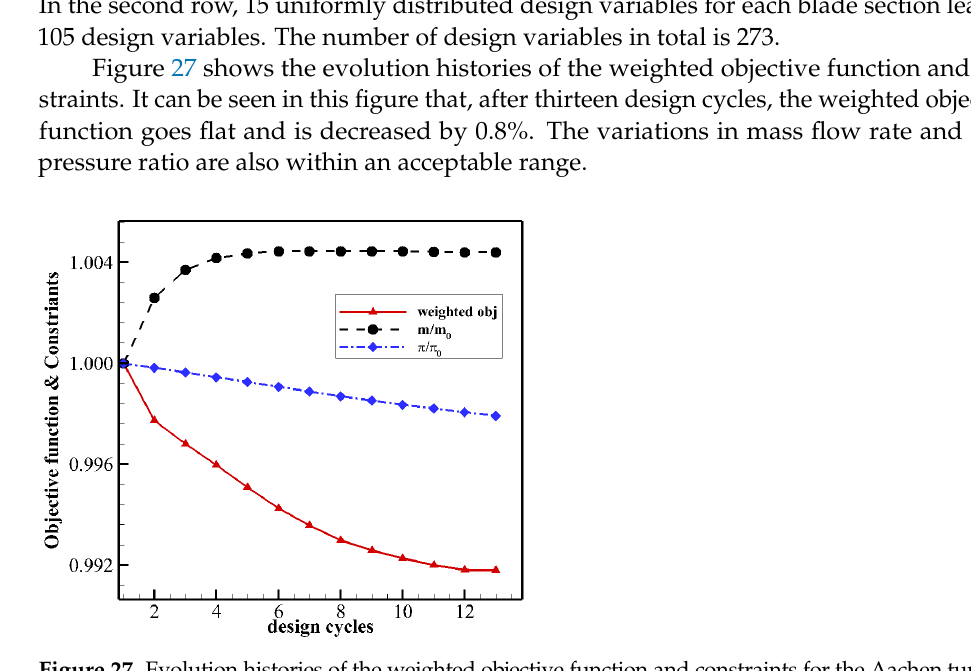
Figure 27. Evolution histories of the weighted objective function and constraints for the Aachen